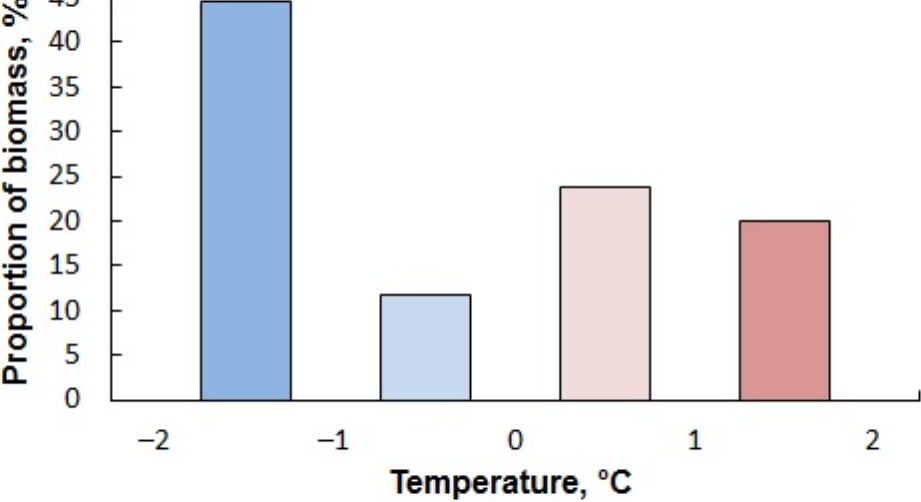
Figure 5. The proportional biomass of ice cod Arctogadus glacialis with temperature across fjord and shelf stations in Northeast Greenland (cf. Table 1 and Figures 1 and 3).